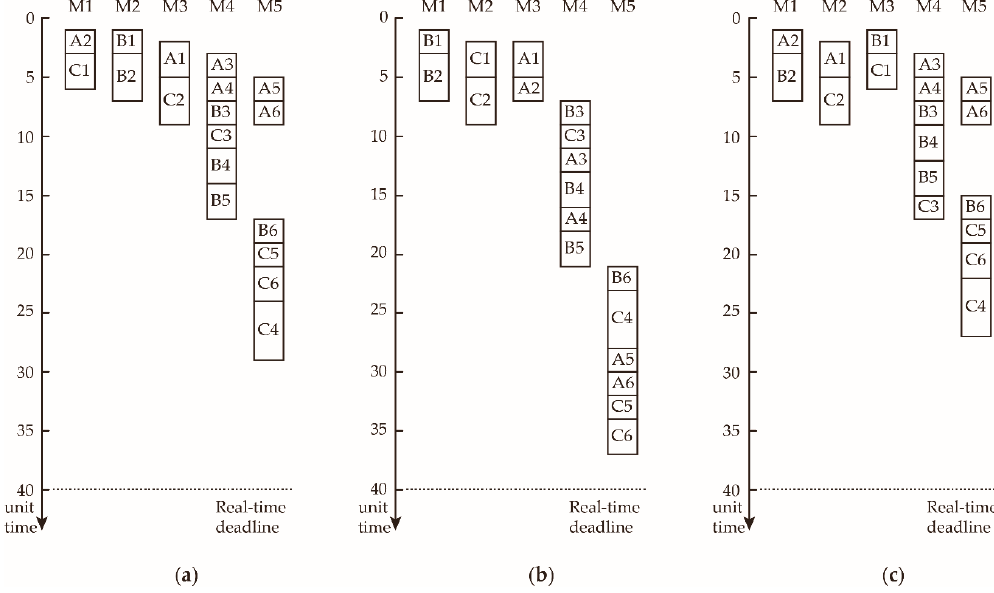
Figure 3. Scheduling examples of three different scheduling algorithms: ( a ) SPT; ( b ) round-robin; and ( c ) heterogeneous earliest finish time (HEFT).